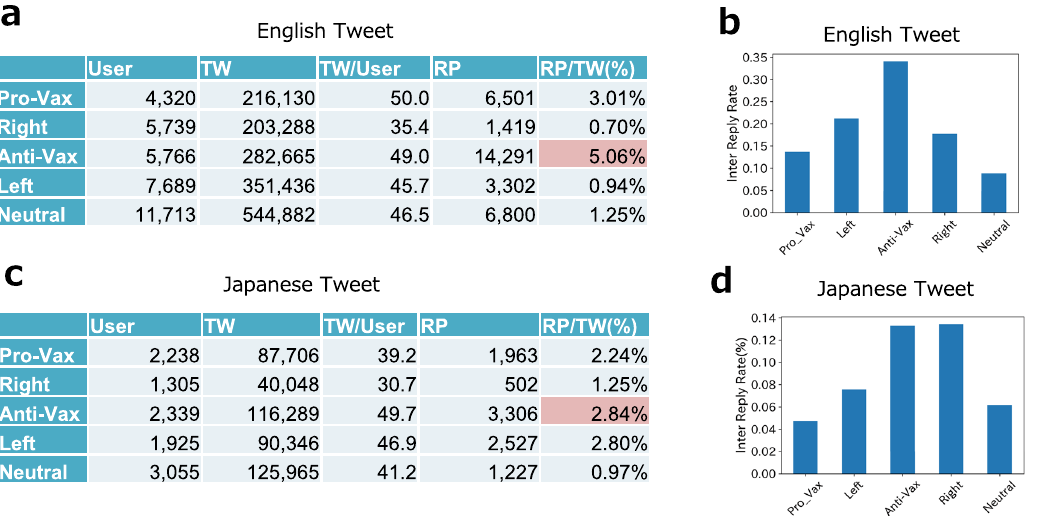
Fig. 2 Tweet and reply activities between clusters. a Reply activities of each cluster in English tweets. Here, TW: tweets. RP: replies. TW includes normal tweets, RP, and RT. Reply rate (RP/TW) was signi fi cantly higher in the Anti-Vax cluster ( χ 2 test: p < 0.001, illustrated in rad shades); b Ratio of inter-cluster replies per all replies from each cluster in English tweets; c and d are the Japanese